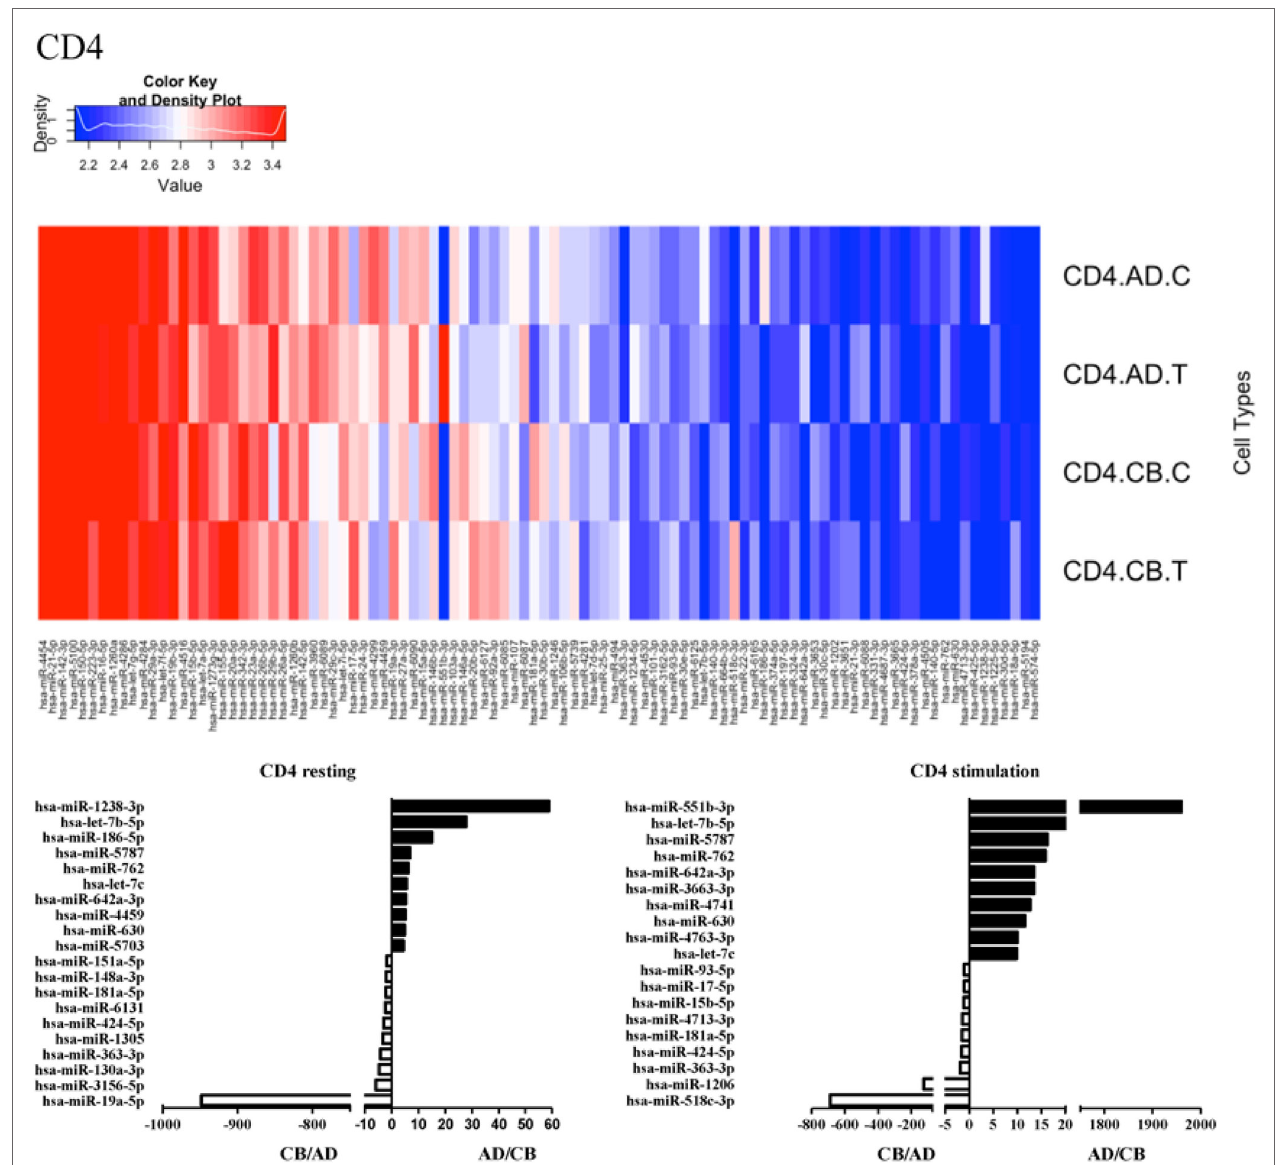
FigUre 4 | Differential microrna profiles between adult and neonatal cD4 + T cells